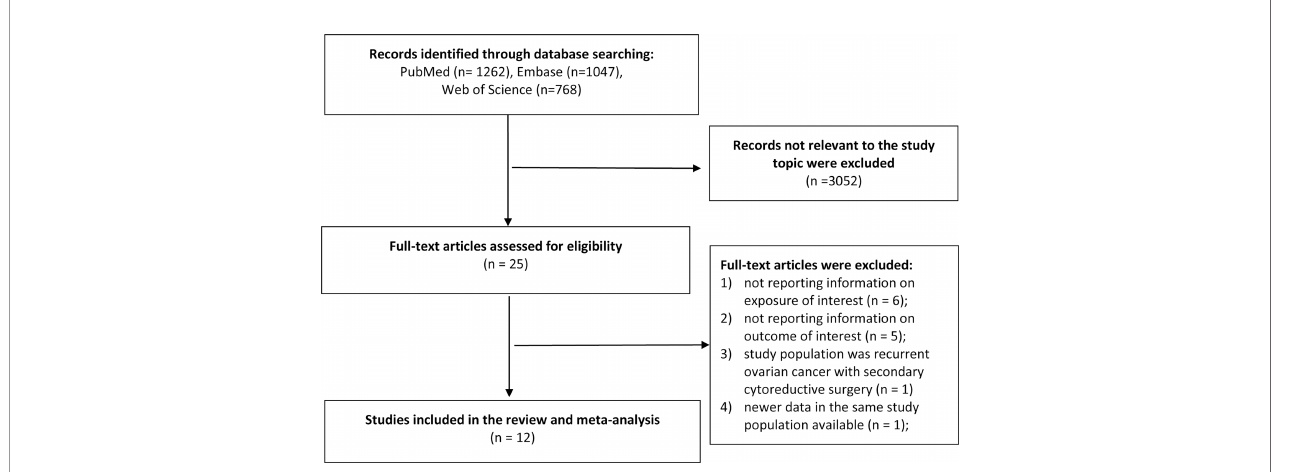
FIGURE 1 | Study selection and identi fi cation in the